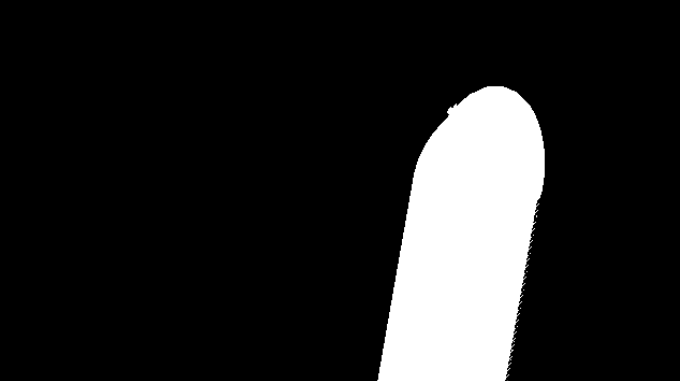
Figure 11. Binary mask of a single object